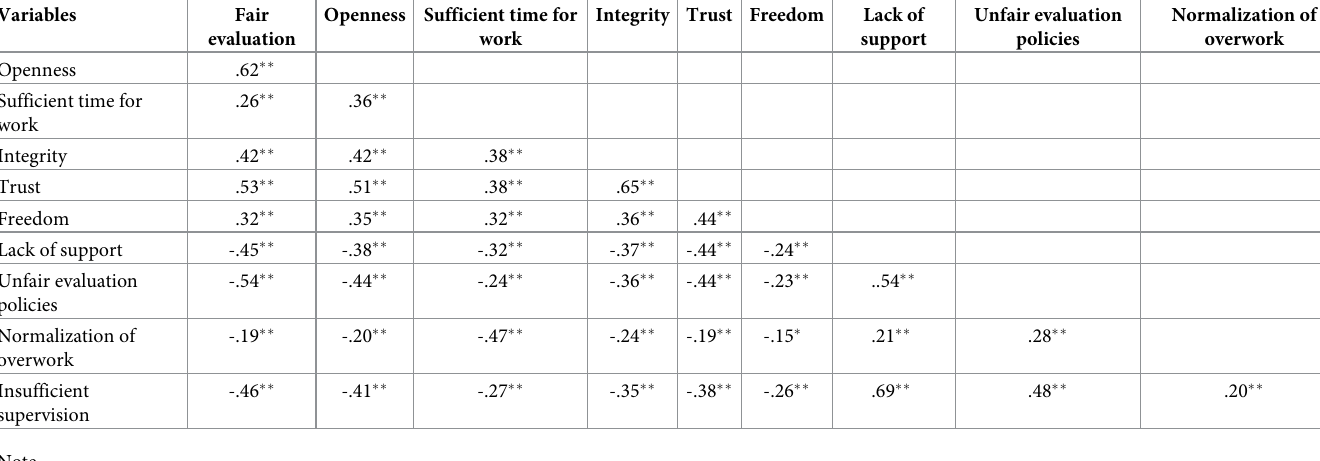
Table 1. Correlations among research climate